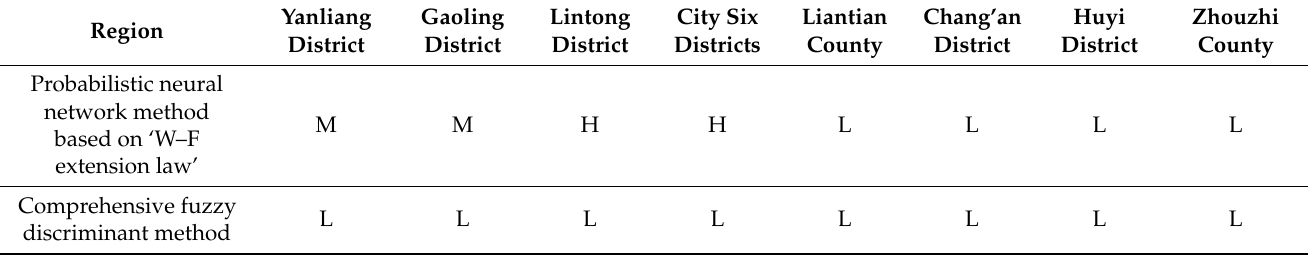
Table 4. Comparative analysis of the results of the evaluation